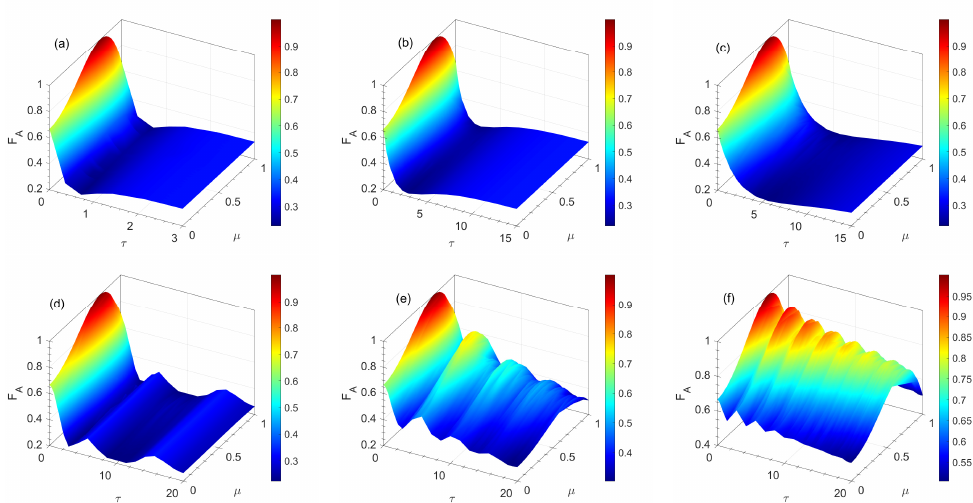
Figure 4. Average fidelity of teleportation versus the scaled time τ = γ 0 t and parameter µ for different values of the Stark shift parameter β in the Markovian regime [( a ) β = 0, ( b ) β = 10 γ 0 , and ( c ) β = 15 γ 0 ] with λ = 10 γ 0 and in non-Markovian regime [( d ) β = 0, ( e ) β = 0.5 γ 0 , and ( f ) β = γ 0 ] with λ = 0.1 γ 0